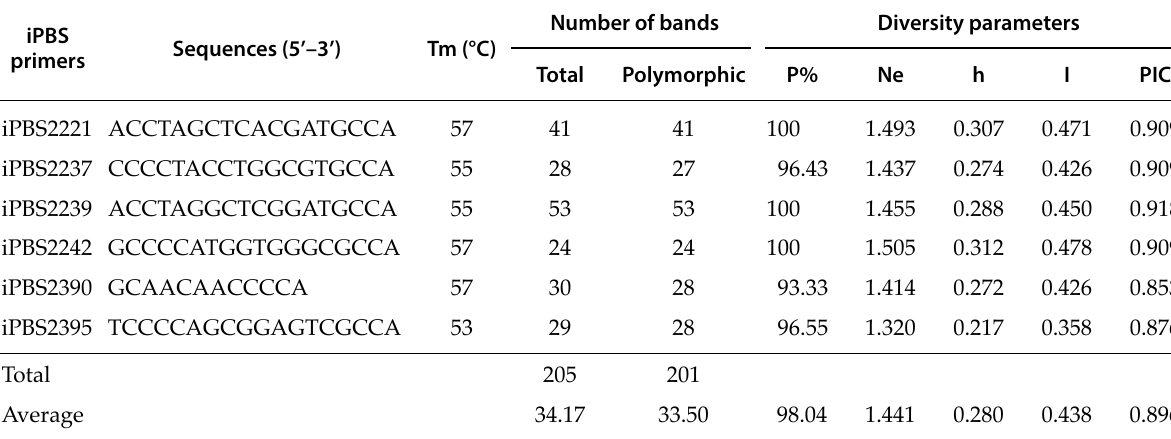
Table 3. Primer names, their sequences, annealing temperatures, numbers of amplified and polymorphic bands, and some diversity parameters of iPBS retrotransposons primers, used in the